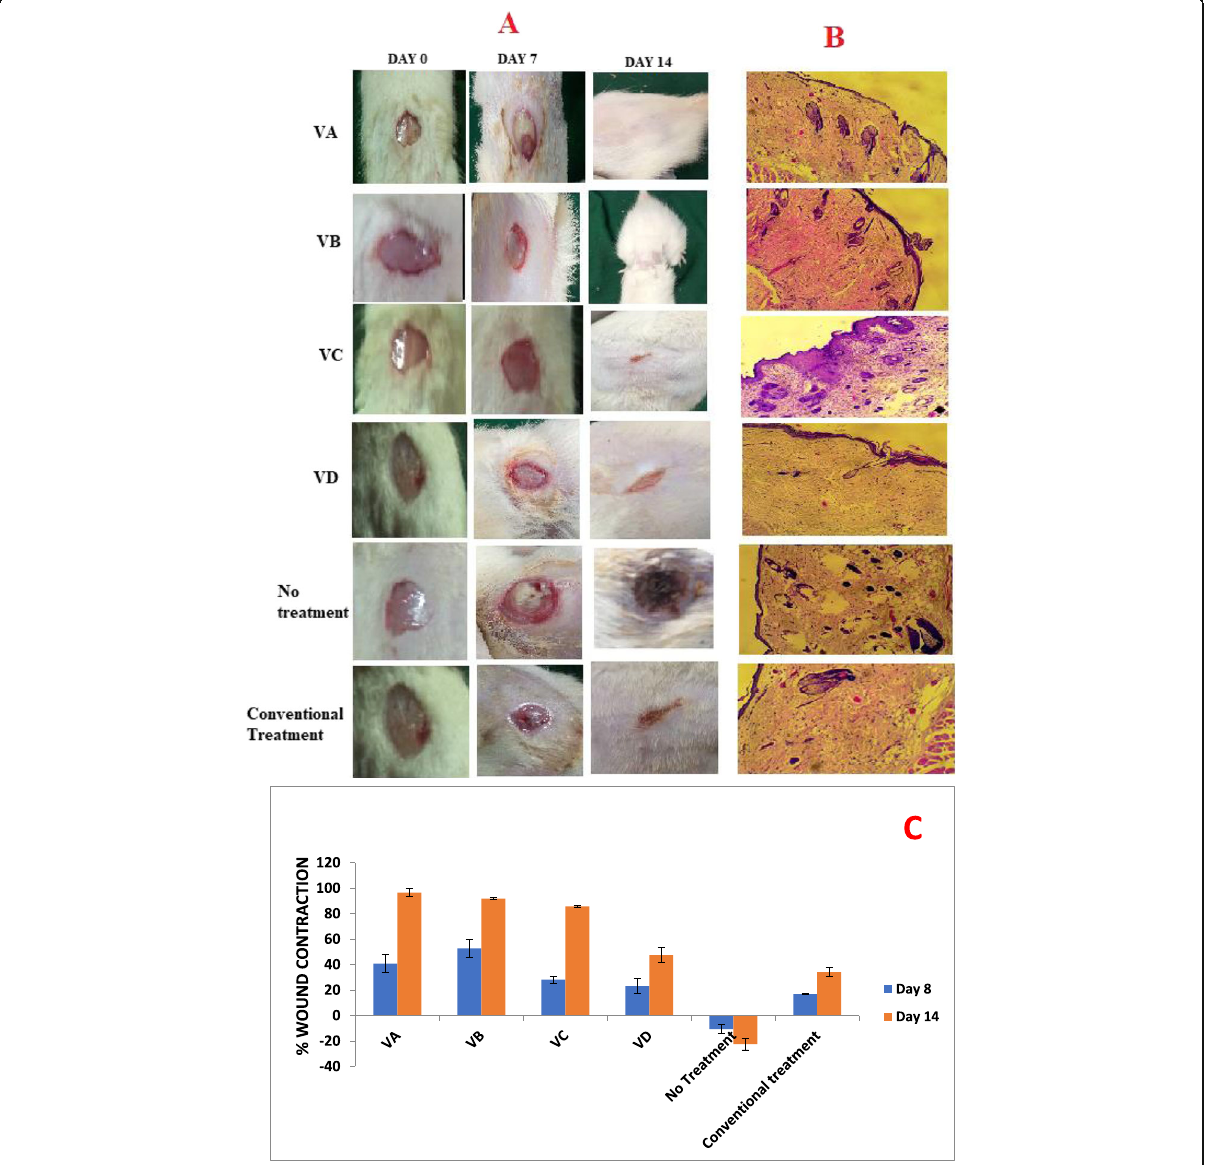
Fig. 5 a Representative images of wounds as days elapsed showing marked difference between varying PLA/HA-valsartan scaffolds VA, VB, VC, and VC, no treatment group cover with gauze and conventional treatment Sofratulle gauze containing fraymycetin sulfate BP 1%. b Representative sections stained with hematoxylin and eosin 15 days post-treatment (H&E). c Percentage wound contraction in the animals treated with varying PLA/HA-valsartan scaffolds and control. N =